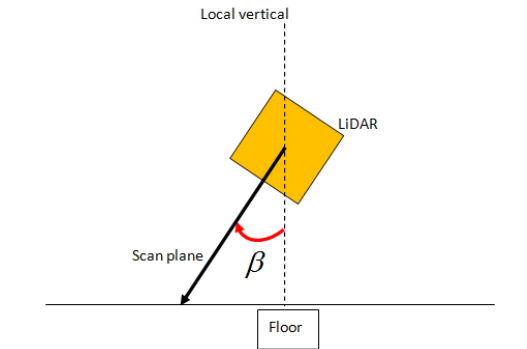
Figure 8: Horizontal plan (floor) scanned with a β angle